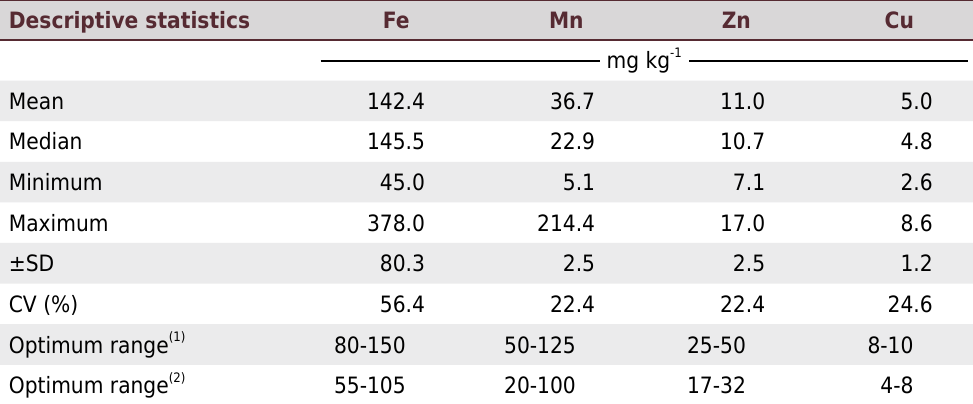
Table 3. Descriptive statistics of micronutrient contents in leaves +3 of sugarcane cultivated in northeast Brazil Descriptive statistics